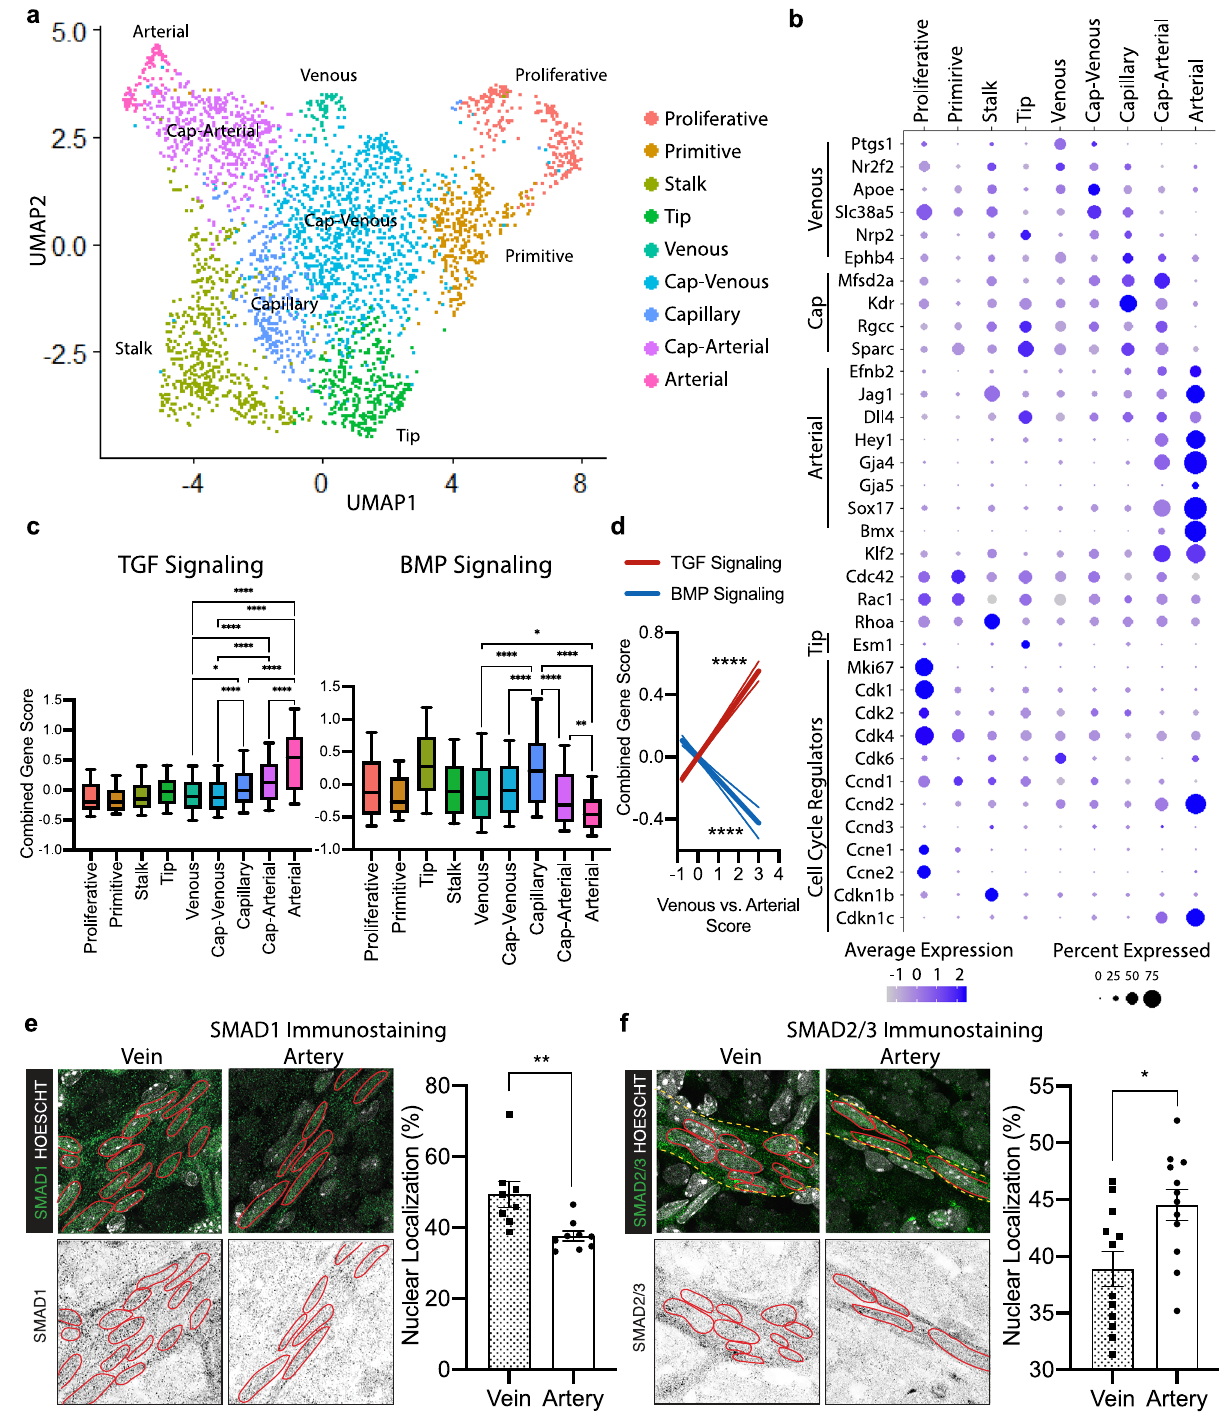
Fig. 3 | Single-cell RNA sequencing analysis of developing retinal endothelial cells.a UMAPdimensionalityreductionplotandclusteringwithlabeledendothelial cell populations. b Dot plot showing expression of genes related to venous, capillary, arterial, fl ow ( Klf2 ), migration ( Cdc42, Rac1, Rhoa ), tip, and cell cycle regulator functions within clusters. c Module scoring within clusters of genes related to TGF Signaling and BMP Signaling (box=25th − 75th percentile, center= median, whiskers=10th − 90th percentile, statistical test one-way ANOVA post hoc Tukey,cellsineachclusterleft-to-right: n =238,312,516,343,60.955,283,486,89). d , Linear regression analysis of each cell comparing Venous vs. Arterial Score to